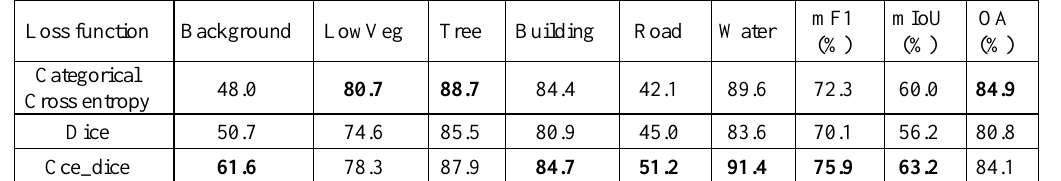
Table 4. Performance of FPN-VGG models trained with different loss functions. The metric for individual class is F1